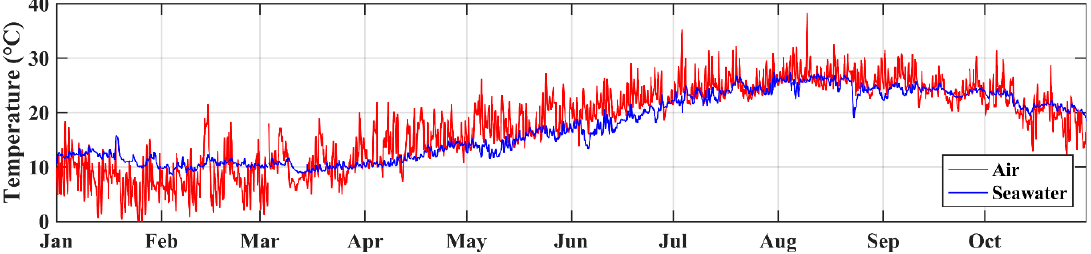
Figure 7. Comparison of 10 min mean air temperature on the pier and seawater temperatures at a depth of 2 m for the period of January to October 2016 at the HORS research platform.